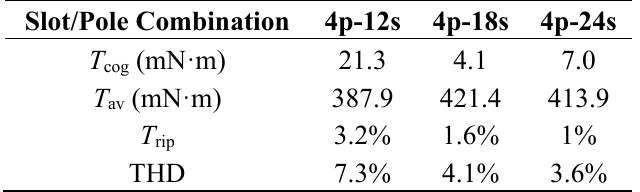
Table 4. Performances of machine with different slot-pole